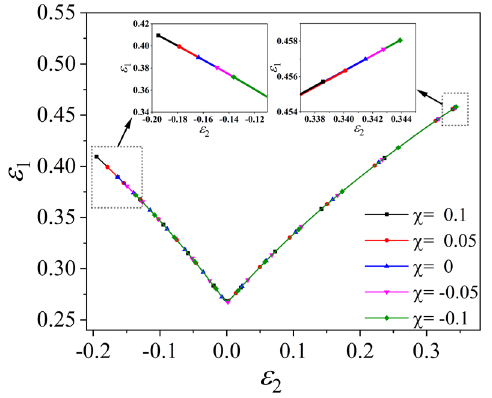
Figure 5. FLD of material TRIP780 based on Mises yield criterion and MMFC instability criterion.